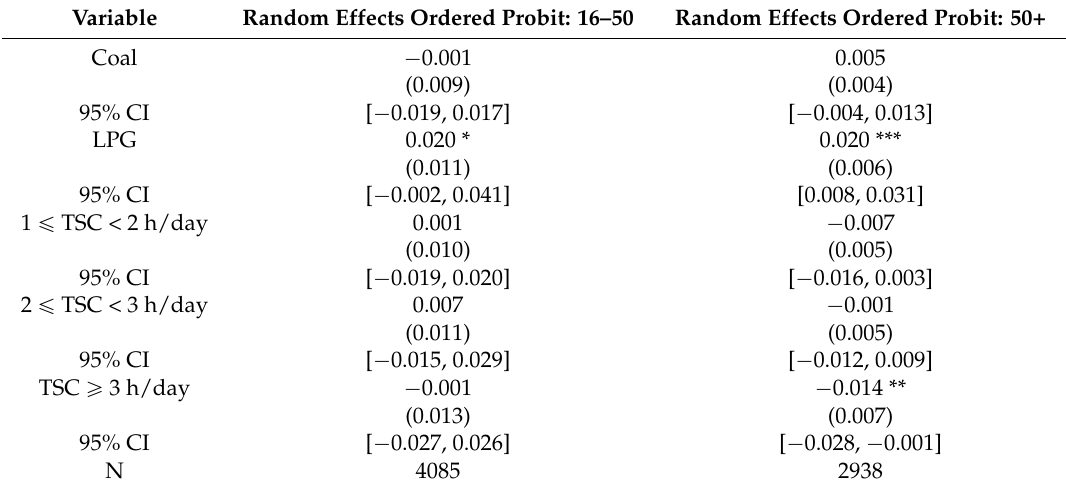
Table A6. Random effects ordered probit estimates for household cooking fuels on women self-reported health in rural area: CHNS